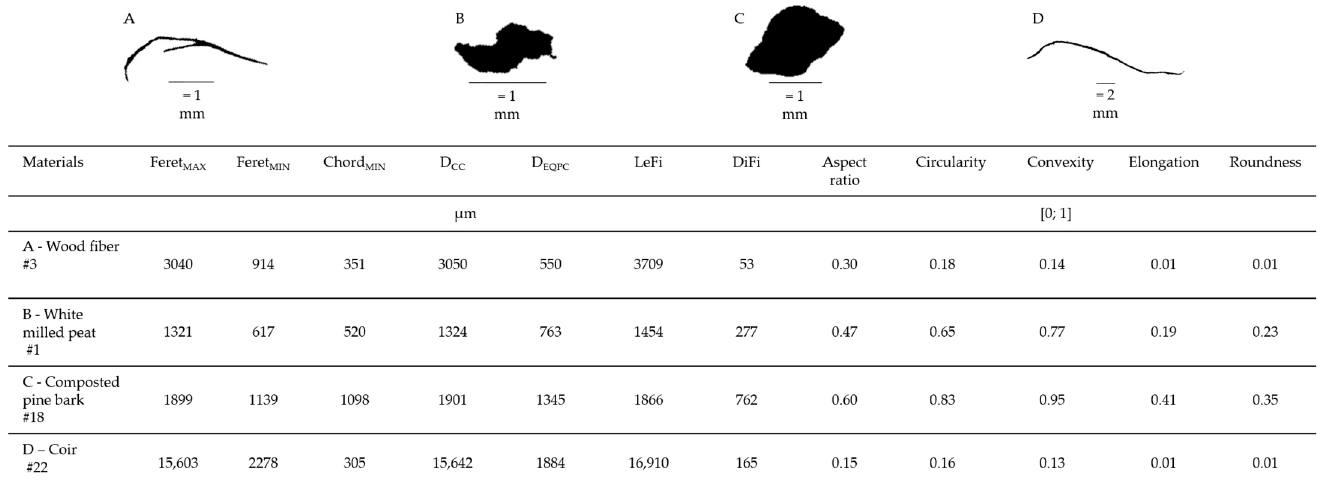
Figure 2. Schematic representation of particle size and shape assessment (Equations (1) to (5)) derived from the calculation of diameters (Feret MIN , Chord MIN , Feret MAX , DiFi [diameter of fiber], LeFi [length of fiber], D CC ), area, and perimeter assessed by dynamic image analysis.